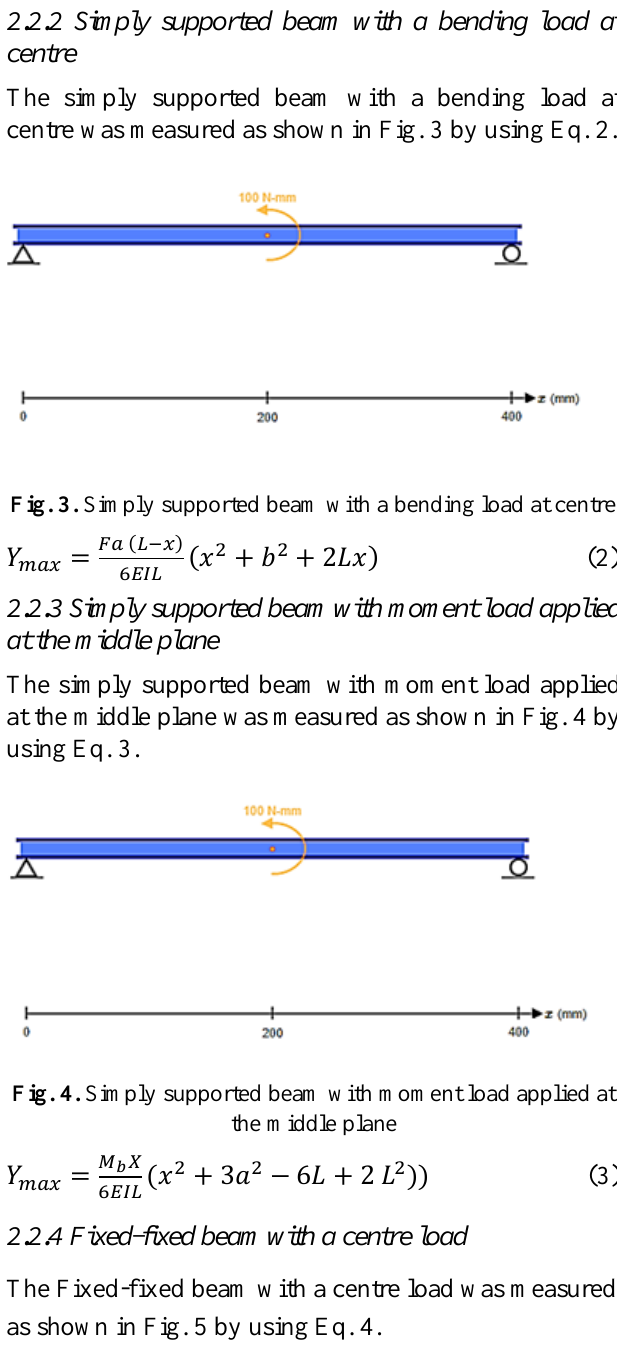
Fig. 2. Cantilever beam (fixed-free) with end load